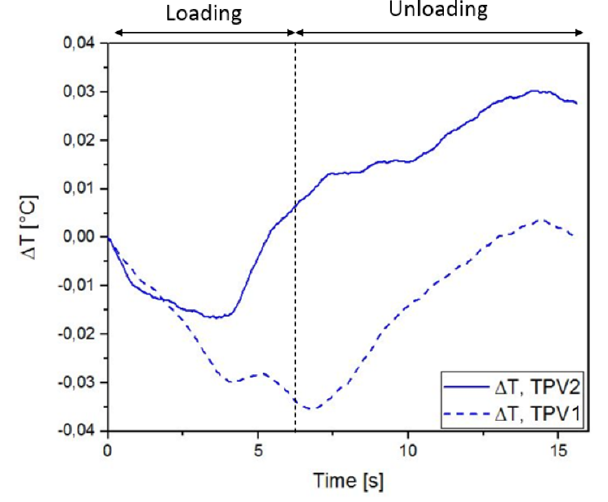
Figure 19. Temperature change with time for specimen overmoulded at 190 ◦ C, in the case of cyclic loading.